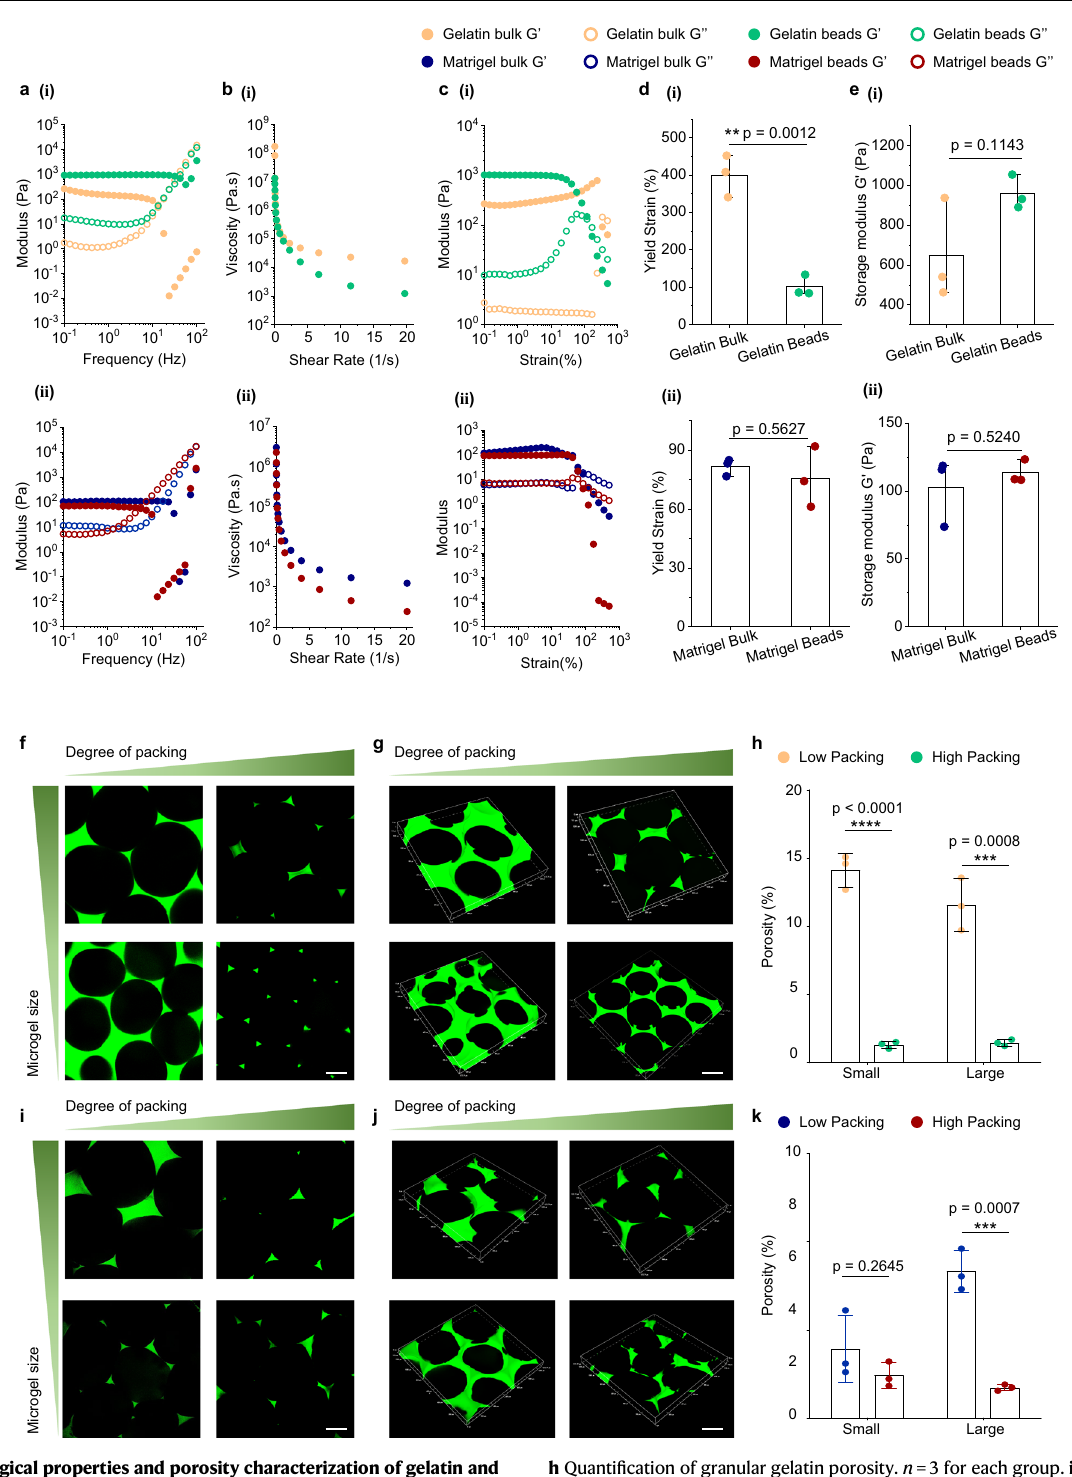
h Quanti fi cation of granular gelatin porosity. n =3 for each group. i – k Repre- sentative confocal 2D ( i ) and 3D ( j ) representative images of granular Matrigel microgelsassembledfromdifferentmicrobeads( D =450and650 µ m)andpacking densities. The bead samples were in fi ltrated with FITC-dextran solution. k Quanti fi cationof granularMatrigelporosity. n =3foreachgroup.Here,the high- packing and low-packing conditions were reached by centrifugation of the microbead assembly for 5min at 93× g or at 20,879× g . Scale bar, 200 µ m. The data arerepresentedasmean±SD.Thesigni fi cantdifferenceisdeterminedbyunpaired two-failed Student ’ s t -test. ** P <0.01, *** P <0.001; **** P